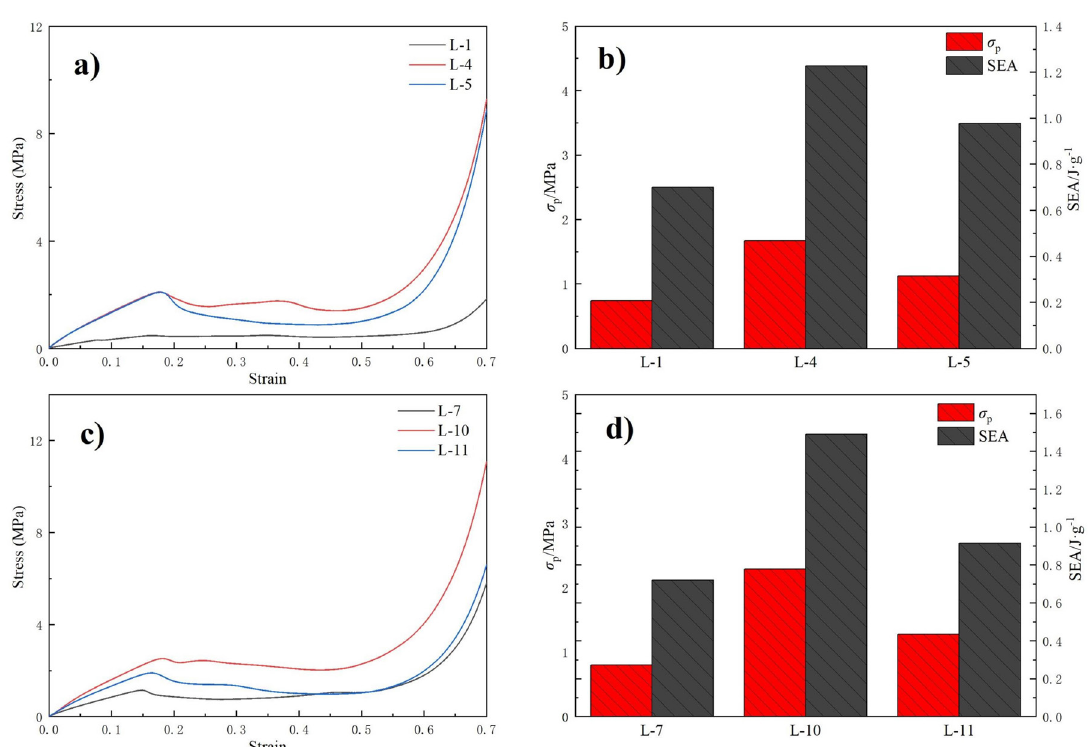
Figure 13. a) Stress-strain curves of different strut distance gradients when straight line, b) Platform stress and SEA of different strut distance gradients when straight line, c) Stress-strain curves of different strut distance gradients when curve line, d) Platform stress and SEA of different strut distance gradients when curve